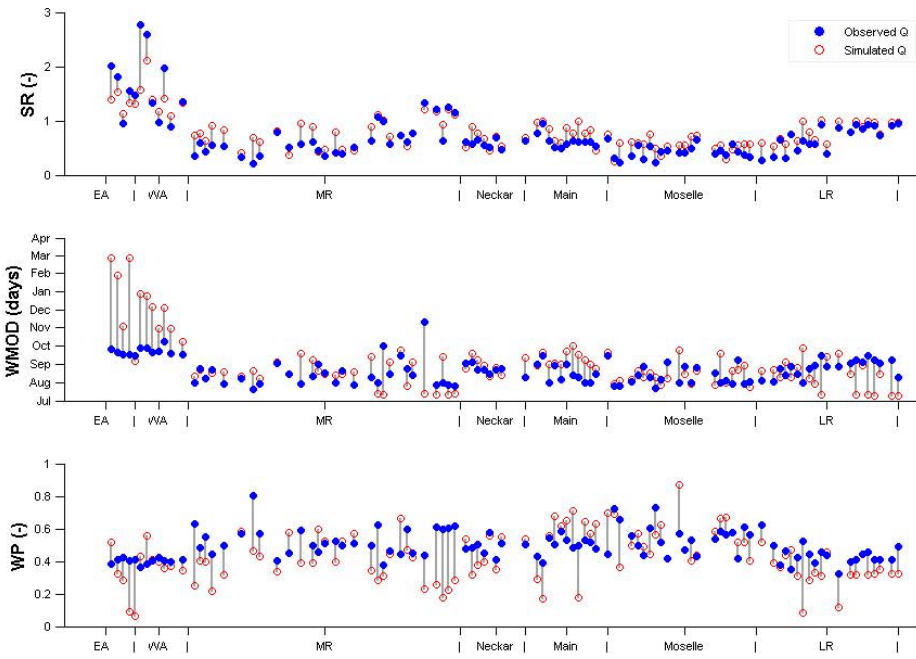
Fig. 2. Three seasonality indices estimated from observed (case 1) and simulated (case 2) low flows in 101 catchments for the period 1964– 2007. The grey line is used to connect observed and simulated indices for each